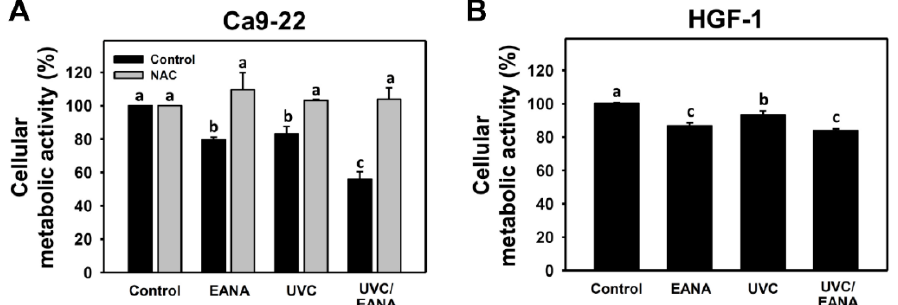
Figure 1. Cell proliferation of the ethyl acetate extract of Nepenthes adrianii × clipeata (EANA) and / or UV treatments for human oral cancer Ca9-22 and normal oral HGF-1 cells. ( A , B ) Cell metabolic activity was determined by MTS assay. With or without NAC (10 mM) pretreatment for 1 h, cells were post-treated with control (DMSO only), EANA (5 µ g / mL), UVC (12 J / m 2 ), and combined treatment (UVC / EANA) for 24 h. Treatments showing no overlapped labels (a–c) di ff er significantly between multiple comparisons ( p < 0.05–0.0001). Data, mean ± SD ( n =